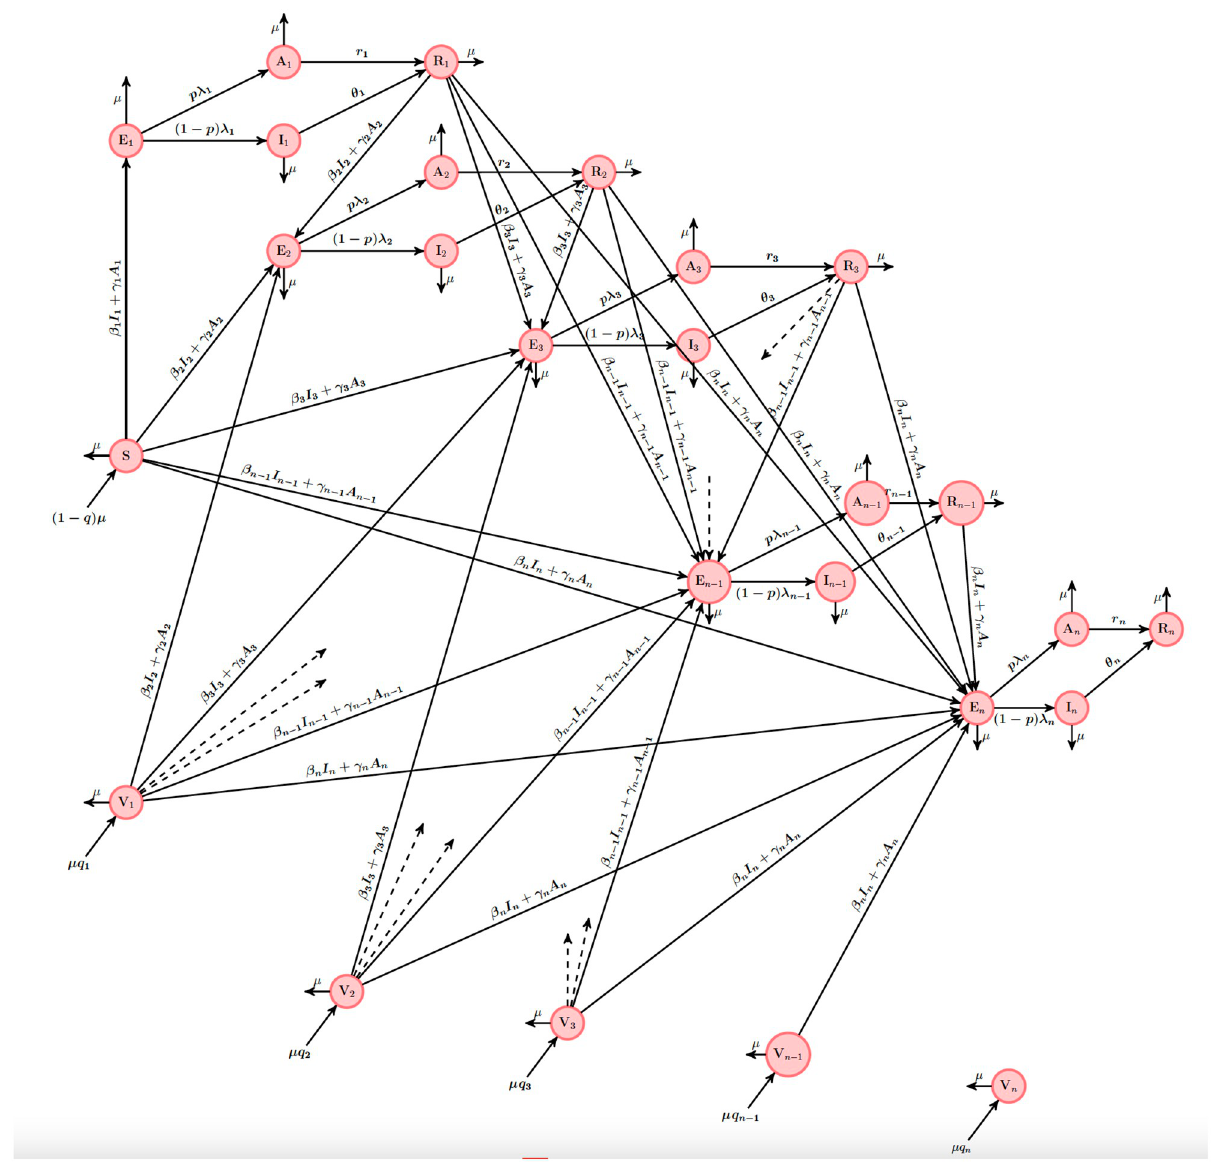
Fig 2. Schematic diagram for the epidemic model (35). The circle compartments represent group of